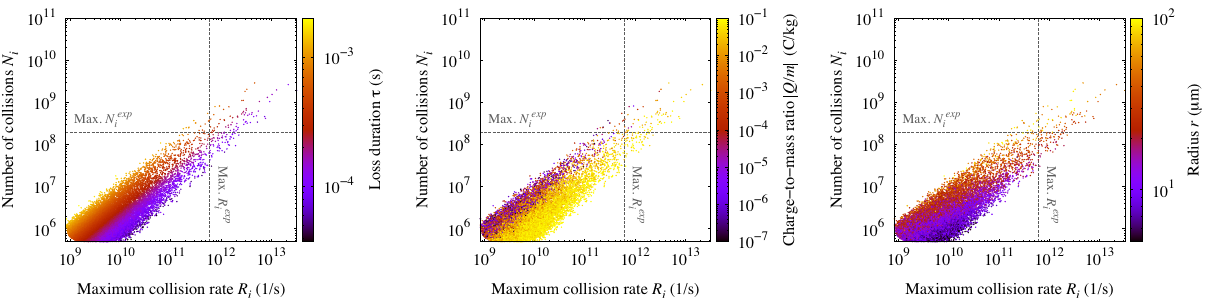
FIG. 9. Scatter plots of randomly sampled dust events based upon the simulation model described in Ref. [22]. The graphs show the number of inelastic proton-dust particle collisions per event versus the maximum collision rate. The color coding indicates the loss duration (left), the charge-to-mass ratio (center) and the radius (right). Only events with ≥ 5 × 10 5 collisions within 640 μ s are shown. See the text for more details about the simulation parameters. The horizontal and vertical lines indicate the maximum N i and R i values observed in the experimental distributions in Fig.